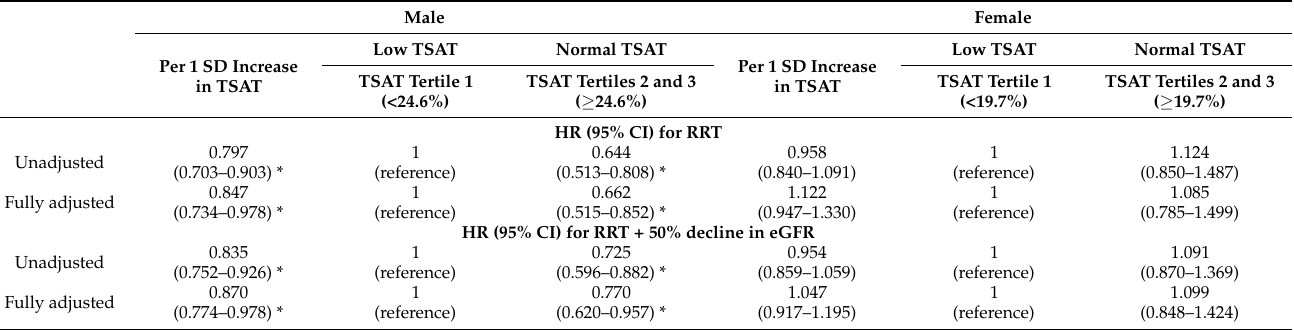
Table 4. Association of TSAT with renal outcomes divided by